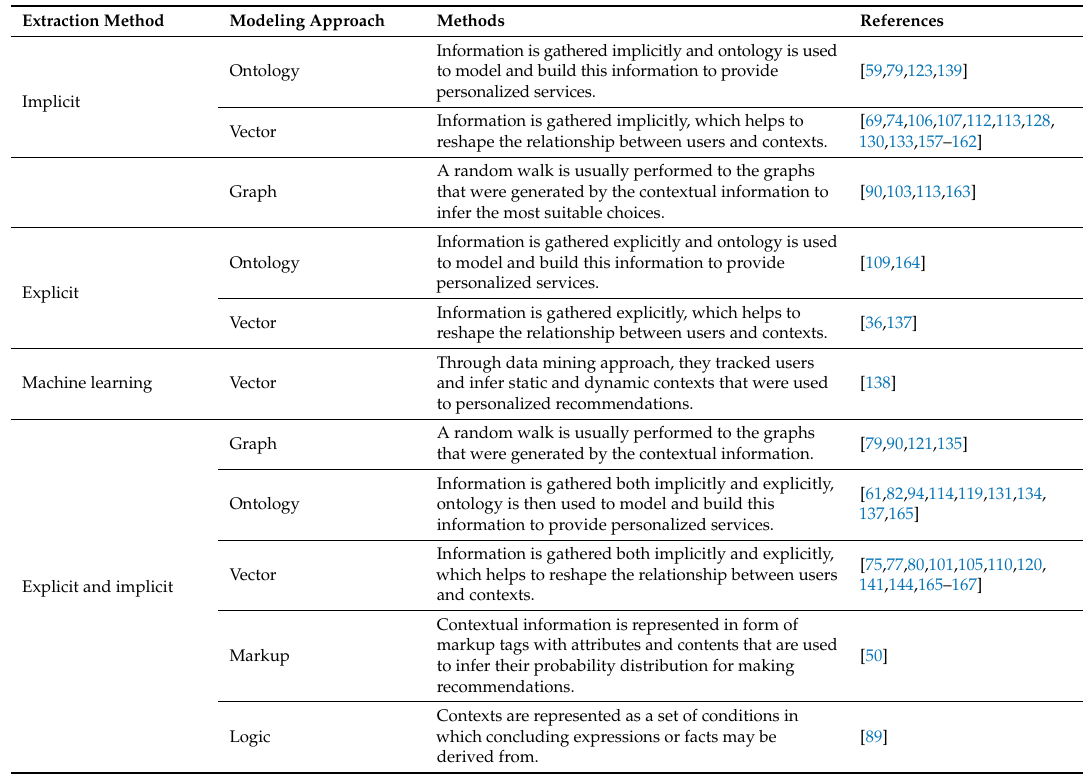
Figure 5. Classification by modeling approach. Table 3. Modeling and extraction